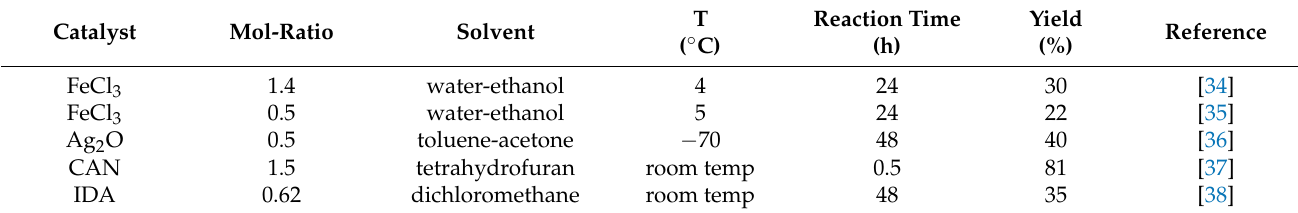
Table 2. Condition for radical dimerization of IE for obtained DHIE.